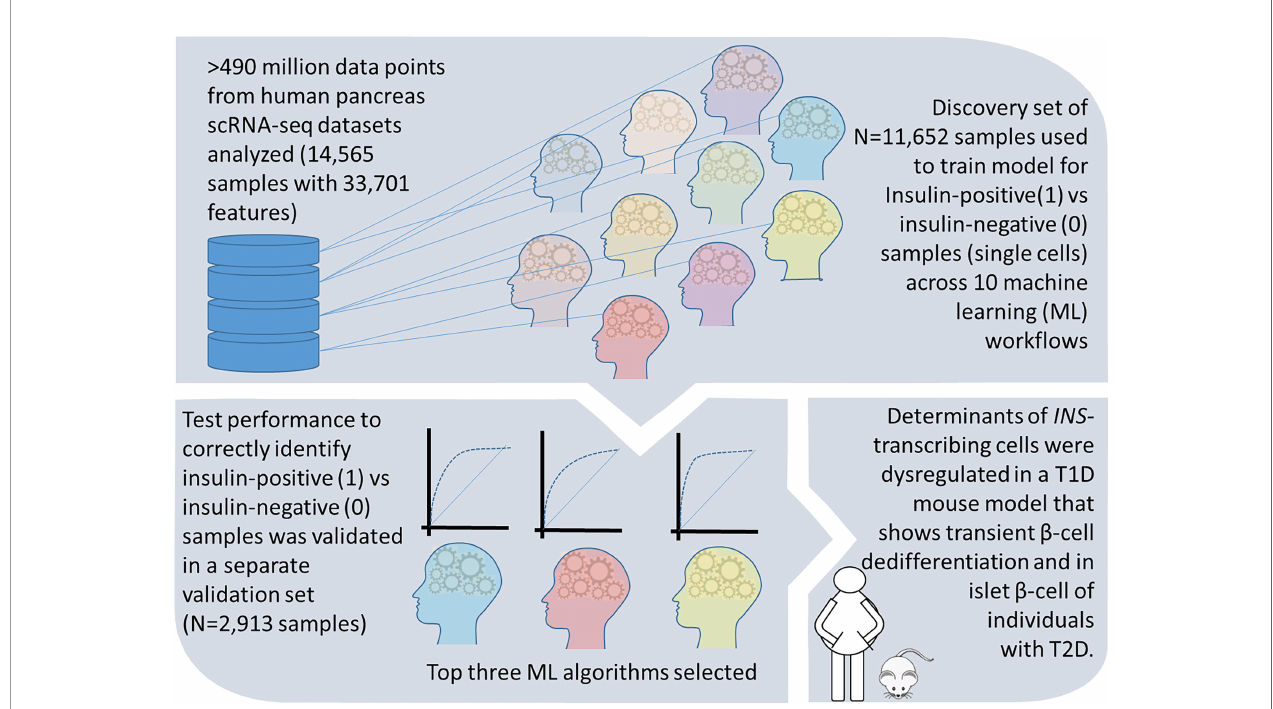
FIGURE 3 | A summary of study design and results. Work fl ow and fi ndings of our study are presented in this schematic, which illustrates the steps in discovery and validation of the important gene features associated with insulin transcript in pancreatic single cell transcriptomes. We further con fi rm these features to be dysregulated during b -cell dedifferentiation in a T1D mouse model and in individuals with